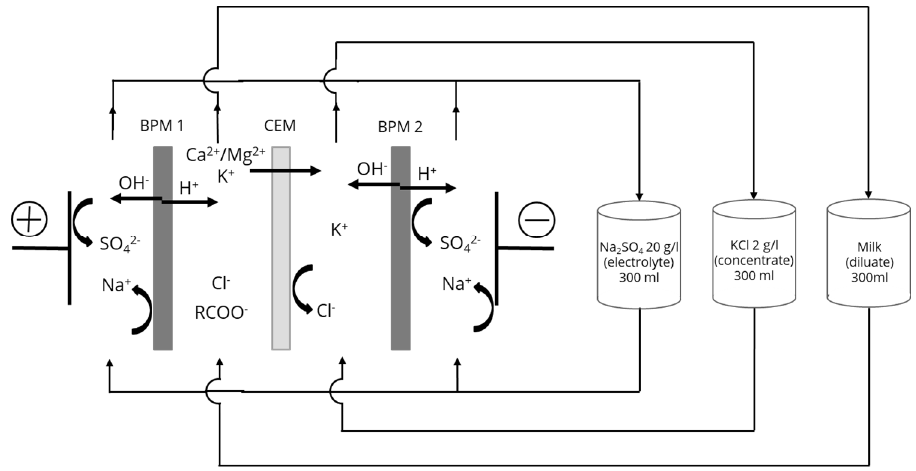
Figure 1. Electrodialysis cell configuration of electrodialysis with bipolar membranes (EDBM) process.